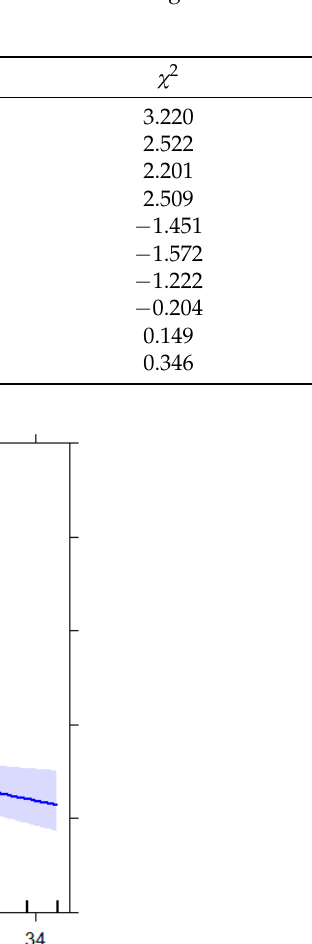
Figure 6. Effect plot of the variable having a significant influence on the number of explorative and scent ‐ marking patterns. The number of explorative and scent ‐ marking patterns (Y axis) decreases as the ambient temperature (X axis) increases. The band represents the confidence interval.